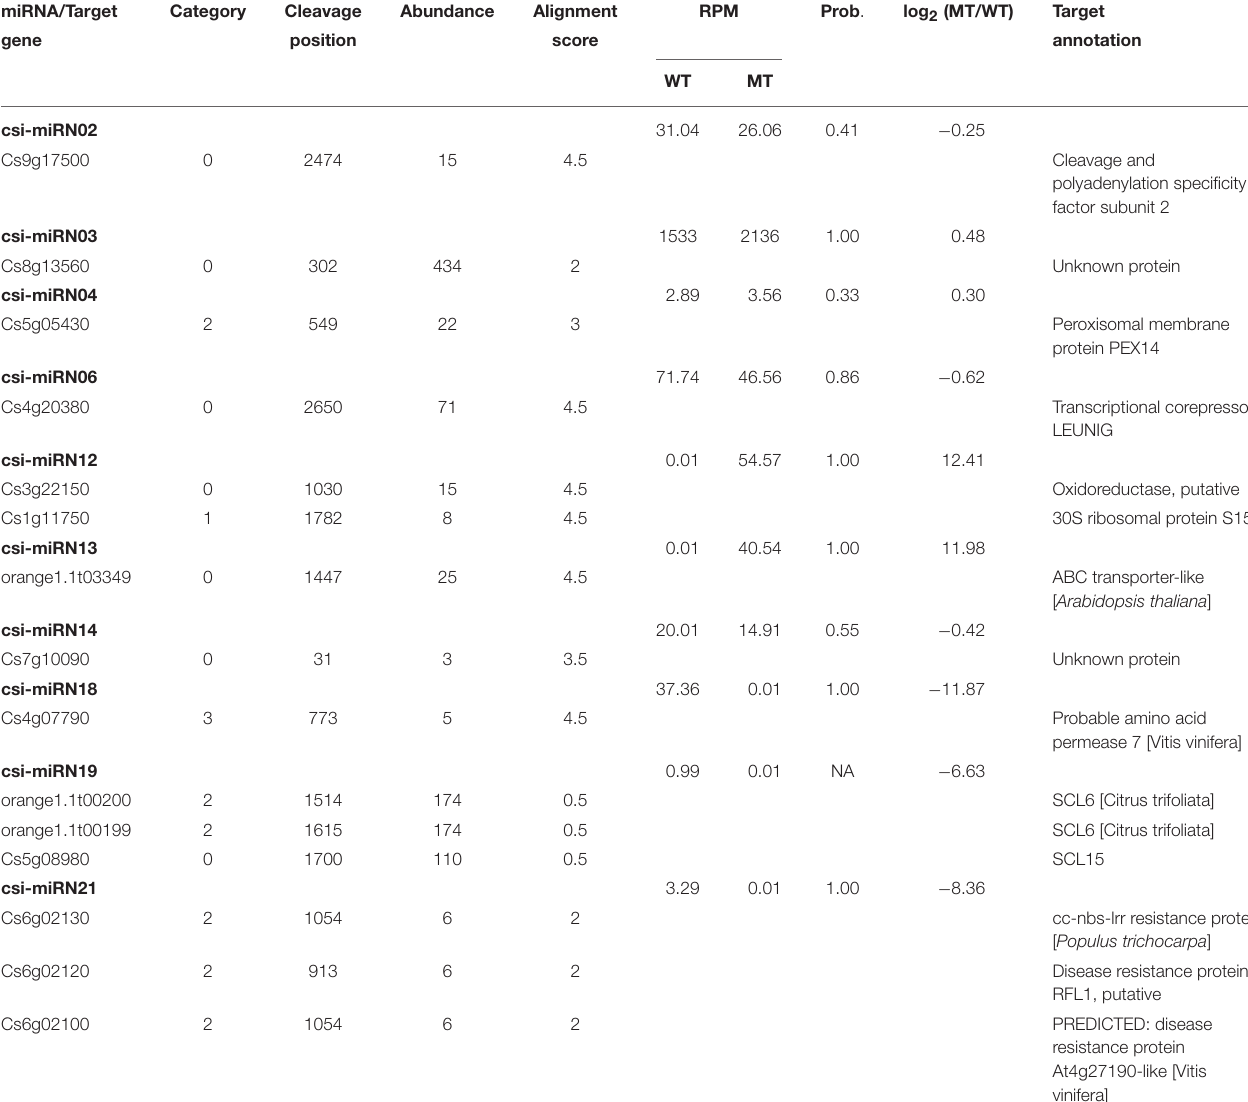
TABLE 3 | Targets of the novel miRNAs identified in MT and WT. miRNA/Target Category Cleavage